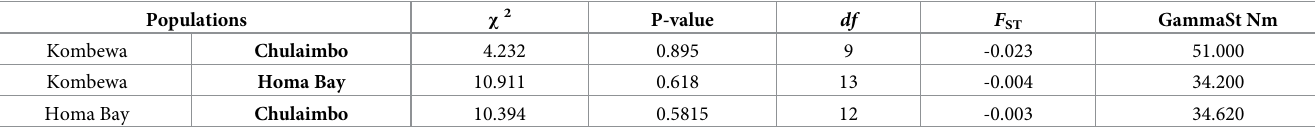
Table 3. Population structure and gene flow among Plasmodium falciparum across Western Kenya regions. Populations